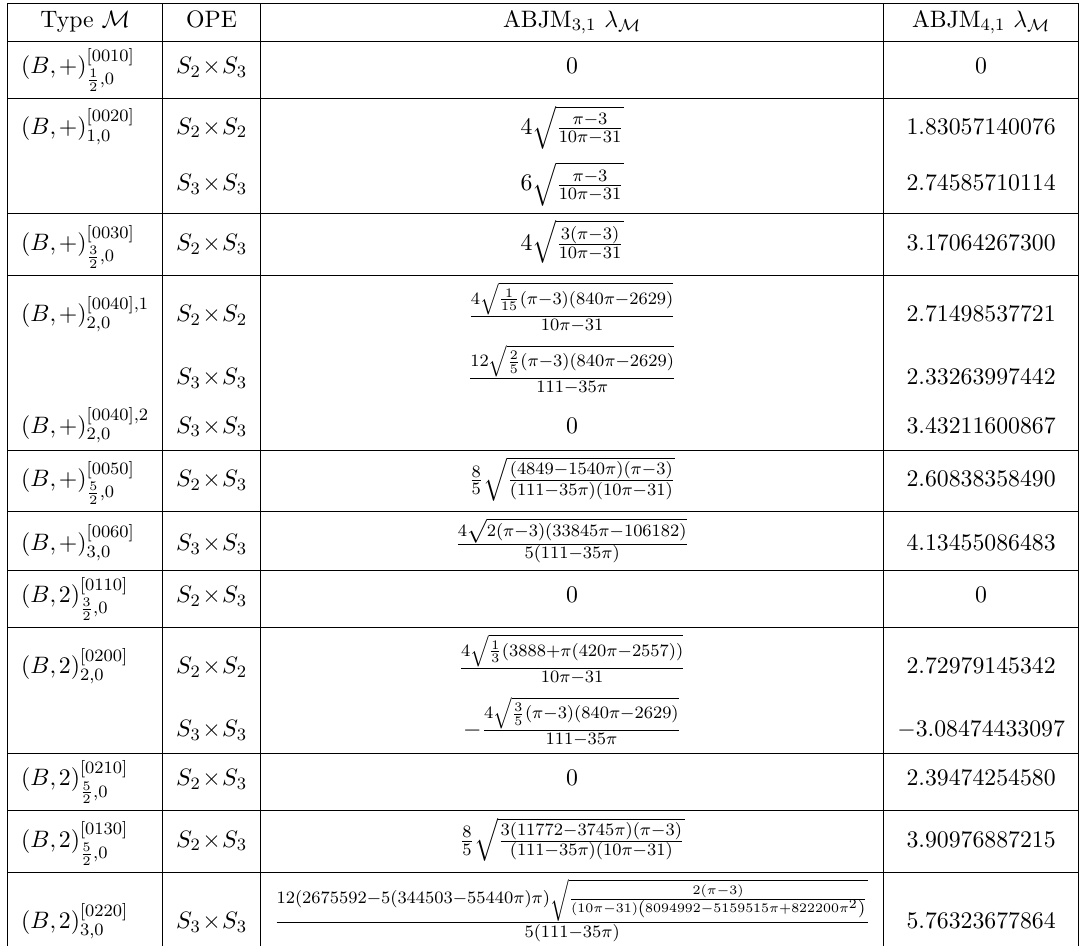
Table 7 . Values of signed OPE coe(cid:14)cients of the superconformal primaries of short multiplets in correlators of S 2 and S 3 in ABJM int appears in both the S 2 (cid:2) S 2 and S 3 (cid:2) S 3 OPEs, while ( B; +) [0040] ; 2